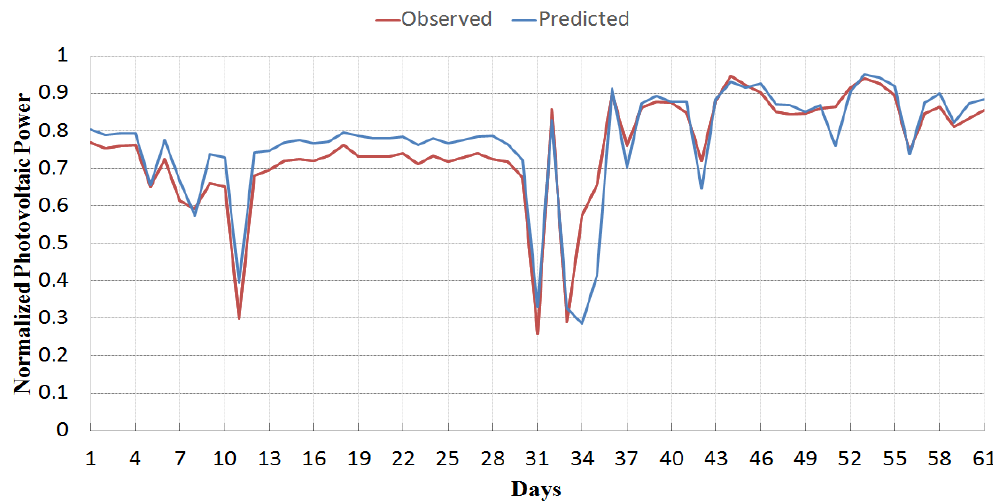
Figure 10. The predicted photovoltaic power values of the WOA-MLP method, which used T A , SR TH , and SR DH inputs.